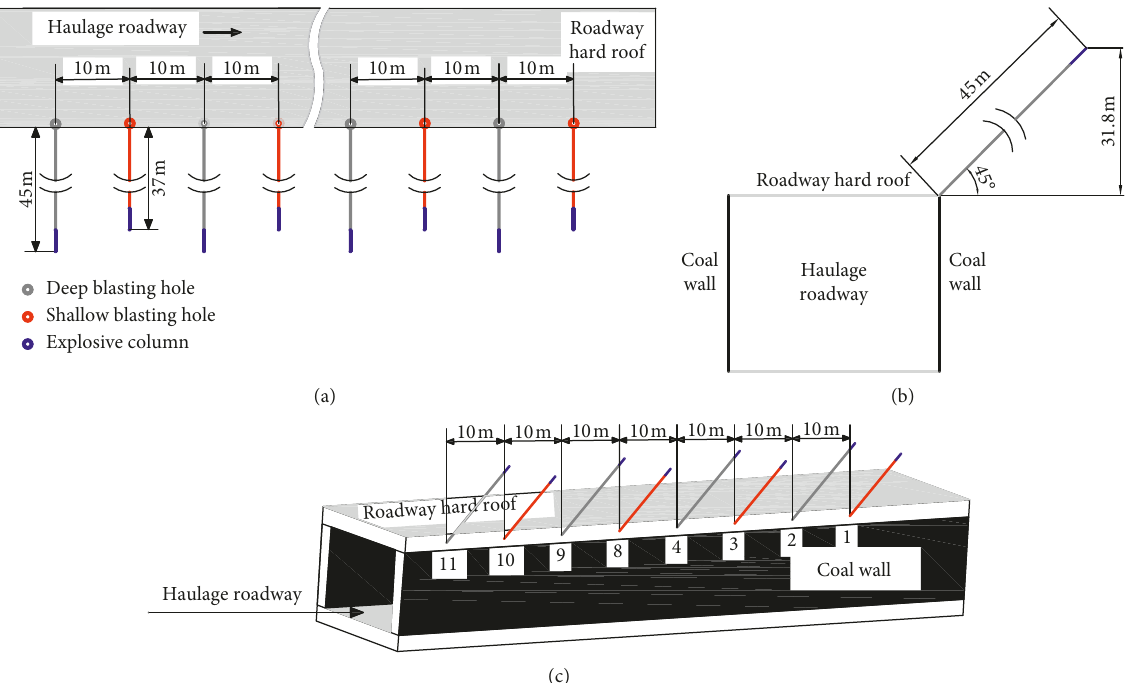
Figure 10: “Deep-shallow-fractal” blasting layout. (a) Top view of blasting layout. (b) Cross-sectional view of blasting layout. (c) 3D drilling